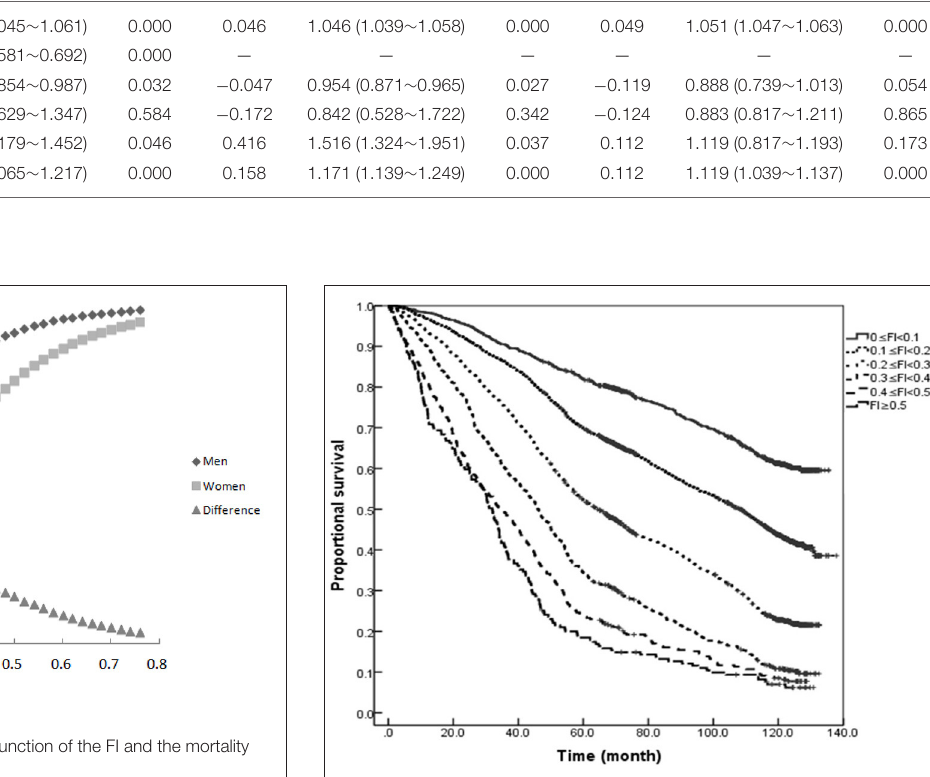
FIGURE 3 | Kaplan–Meier curves for the proportional survival of older men with different degrees of frailty.